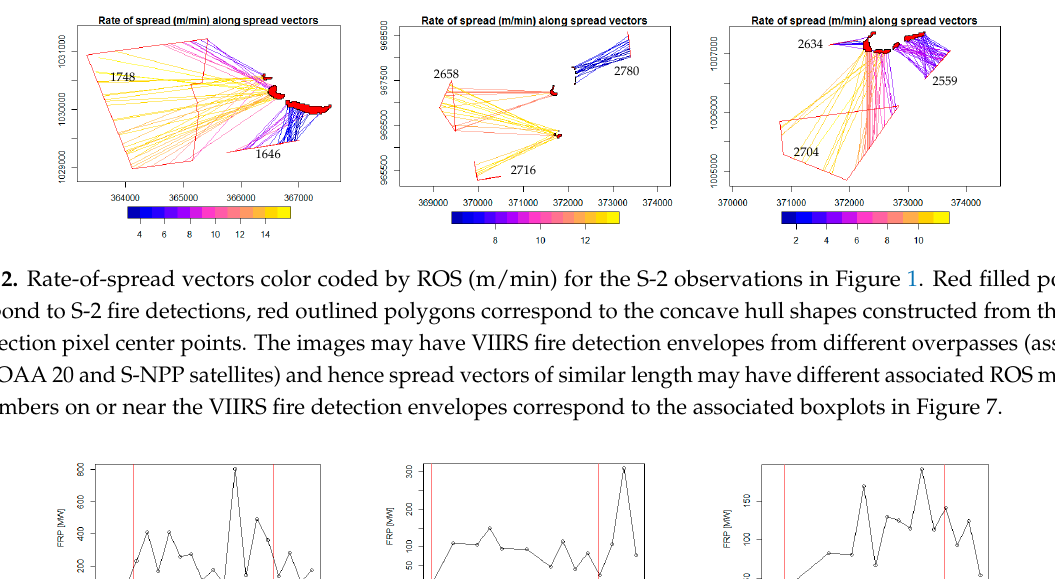
Figure 5. Color coded fire intensities (kW/m) derived for the fire fronts of Figures 1 and 2 (for further details refer to Figure 2). Figure 3 shows the summed FRP from Meteosat SEVIRI. This summation is based on a selection process of Meteosat active fire detections based on their proximity to any of the VIIRS and S ‐ 2 fire detections that are joined to each other through potential spread vectors. These envelopes are therefore in many cases larger than the footprints of the fire clusters in Figures 2 and 5. This is due to the coarse spatial resolution which makes it impossible to resolve the FRP attributed to a specific fire cluster in more spatial detail. The relation to FC per unit area is illustrated in Figure 4, which shows the envelopes based on the S ‐ 2 and VIIRS fire detections which circumscribe the area that has potentially been burned between the S ‐ 2 and VIIRS overpasses. An unknown, though probably not very large, error is introduced here as fires may have ignited after the S ‐ 2 overpass and went out before the VIIRS overpass and therefore leave no traces in the burned area envelopes but do contribute to the FRP detected by Meteosat, which would lead to an overestimation of FC and consequently FI. FC per unit area is then derived from the burned area that was mapped by using S ‐ 2 data obtained after the S ‐ 2 overpass used for ROS analysis. Accuracy of the burned area product hence also influences FC estimates, as commission errors contribute to underestimating FC while omission errors contribute to overestimating FC. Artefacts can be seen for instance in the left panel of Figure 4, where the area in front of the S ‐ 2 fire fronts was not mapped as having been burned after the S ‐ 2 overpass.